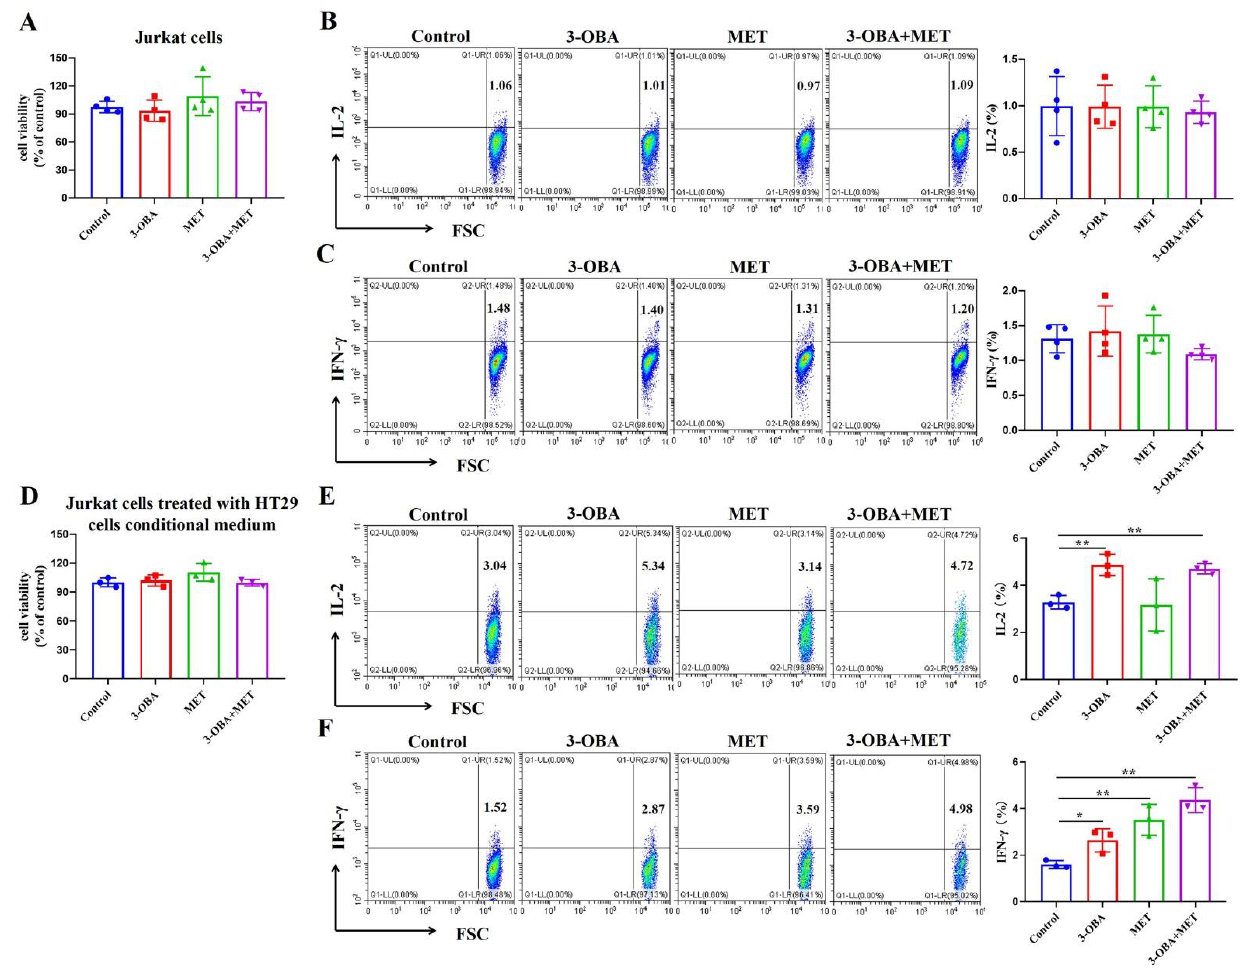
Figure 4. Effects of the combination of 3-OBA and metformin in the proliferation and functions of Jurkat cells. After treatment with 15 mM 3-OBA, 5 mM metformin, or the combination, ( A ) cell viability and ( B , C ) the secretions of IL-2 ( B ) or IFN- γ ( C ) by Jurkat cells were measured. After treatment with the conditional medium from HT29 cells treated by 3-OBA, metformin, or their combination, ( D ) cell viability and ( E , F ) the secretions of IL-2 ( E ) or IFN- γ ( F ) by Jurkat cells were monitored. Representative histograms of at least three independent experiments were shown. * p < 0.05, ** p < 0.01.